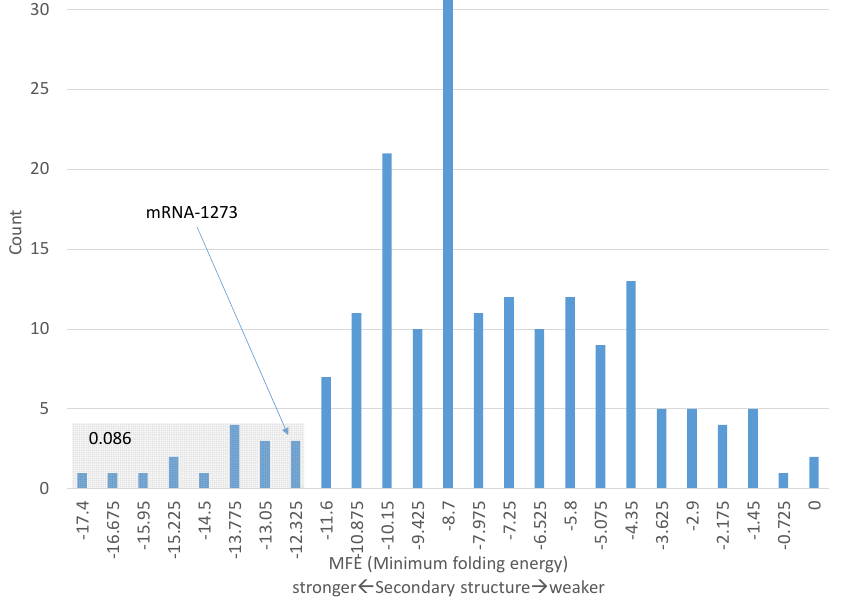
Figure 3. MFE (minimum fold energy) distribution of sequences flanking the start codon AUG in ribosomal protein genes. MFE is calculated from 40-nt with 20 nt upstream of AUG and 20 nt downstream including AUG), based on 186 mRNA variants of 34 RPS and 54 RPL genes. A total of 8.6% of MFE values are equal to, or smaller (more stable secondary struc- ture) than, MFE for mRNA-1273. A number of highly expressed human genes have comparable secondary structure at 5’-UTR. For example, the 40-nt window (with 20 nt before the start codon AUG and 20 nt in the 5’ end of CDS) for human α -globin gene has an MFE of − 11.1, indicating only a slightly weaker secondary structure relative to the corresponding region in mRNA-1273 with an MFE value of − 12.3. However, mammalian highly expressed genes are typically far more GC-rich in sequences flanking the start codon than lowly expressed genes, so the former tend to have more stable secondary structure than the latter. This difference in GC- richness between highly expressed and lowly expressed genes is true both in 5’-UTR im- mediately upstream of the coding sequence and in 3’-UTR immediately downstream of the coding sequence. The 5’-UTR of SARS-2-S mRNA produced natively by SARS-CoV-2 might also be considered as an option. Coronaviruses generate subgenomic mRNAs for translating structural proteins including the spike protein [59,60]. The hypothesized discontinuous transcription is illustrated for the generation of SARS-2-S mRNA (Figure 4) as it has not been done so explicitly before. All subgenomic mRNA transcripts share the same 5’ end leader sequence located at the 5’ end of the genomic sequence (sites 1–70, Figure 4A). This leader sequence includes a transcription regulatory sequence (TRS-L) at its 3’ end (Figure 4A). The coding sequence (CDS) of the spike protein, as well as all downstream coding sequences, features a TRS (TRS-B) upstream of the CDS. The transcription of the subge- nomic negative strand pauses at TRS-B, resulting in the negative strand shifting position from base-pairing with TRS-B to base-pairing with TRS-L (Figure 4B). Transcription of the negative strand then resumes. Subgenomic mRNAs for the spike protein gene and all